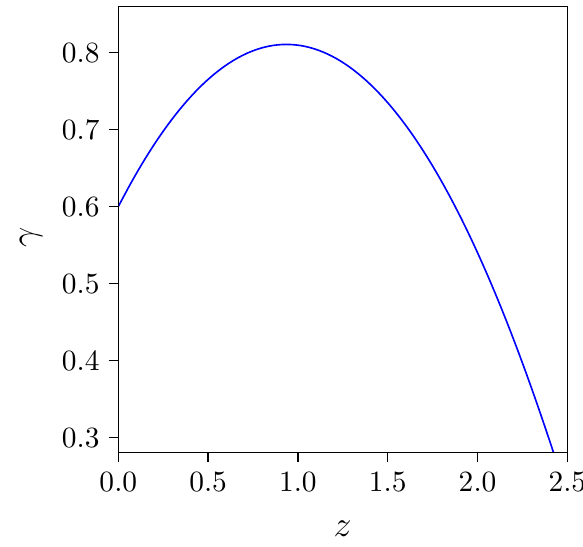
Fig. 4 A demonstration of γ = γ 0 + γ 1 z + γ 2 z 2 with γ 0 = 0 . 6, γ = 0 . 45, γ = − 0 . 24, which are all well within the 1 σ regions of 1 2 their observational constraints for the z -2 case (see Tabel 2 and Fig. 1)